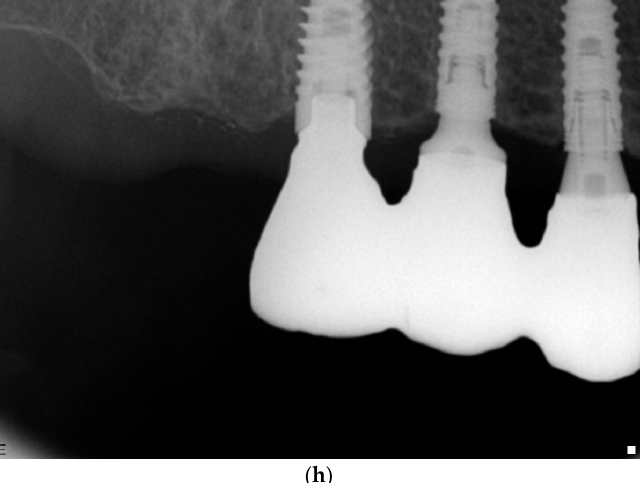
Figure 2. ( a – h ) Maxilla: ( a ) Two implants replacing missing right first and second premolars in an 83-year female. The implants shoulder was flushed with the bone. ( b ) Multiunit (test) and healing (control) abutments were connected after final seating of the implants. ( c ) Twenty-four weeks after placement, healthy peri-implant keratinized gingiva. ( d ) Healthy sulcular epithelium at both test (second premolar) and control (first premolar). ( e ) Transfer adaptation for “open tray “impression technique. ( f ) Radiographic transfer adaptation. ( g ) Final crowns at the 3-year follow-up. Opened embrasure spaces for enhanced interproximal plaque control. ( h ) Radiographic evaluation at the last follow-up (3-year) presents stable crestal bone level in both test and control sites.